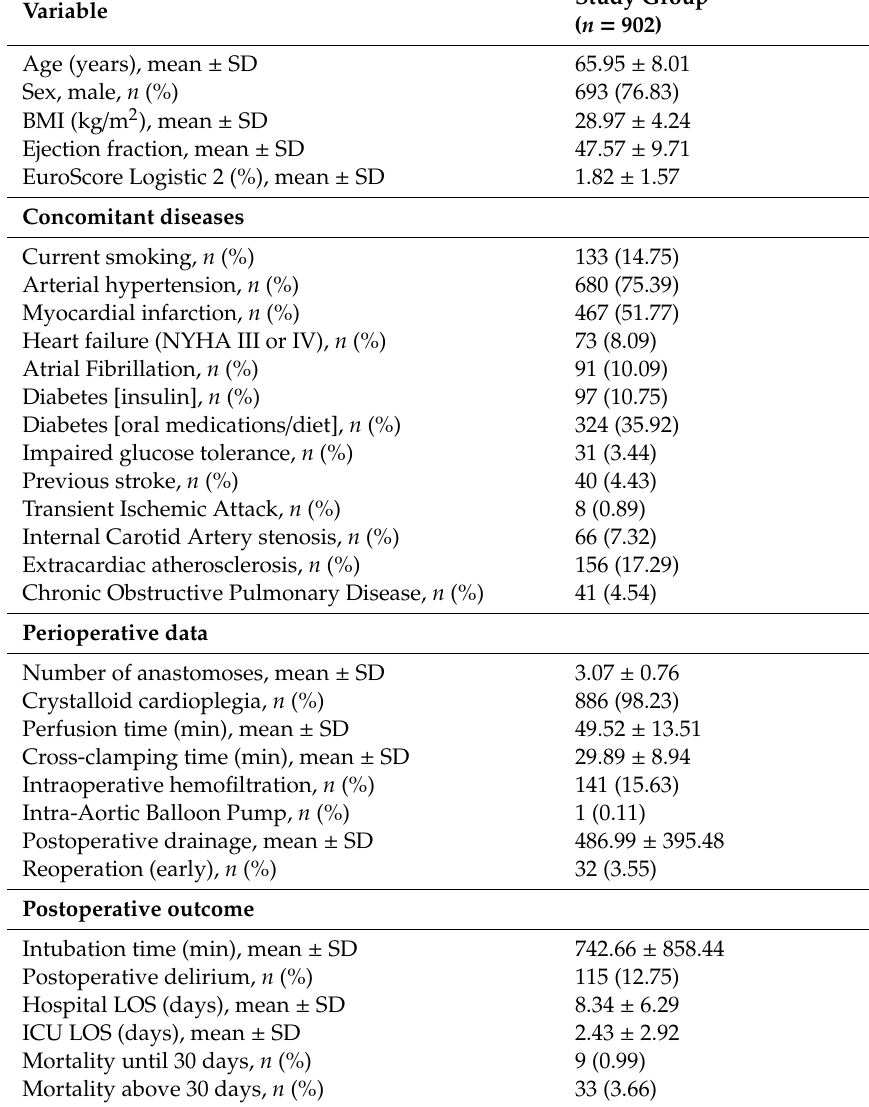
Table 1. Study-group